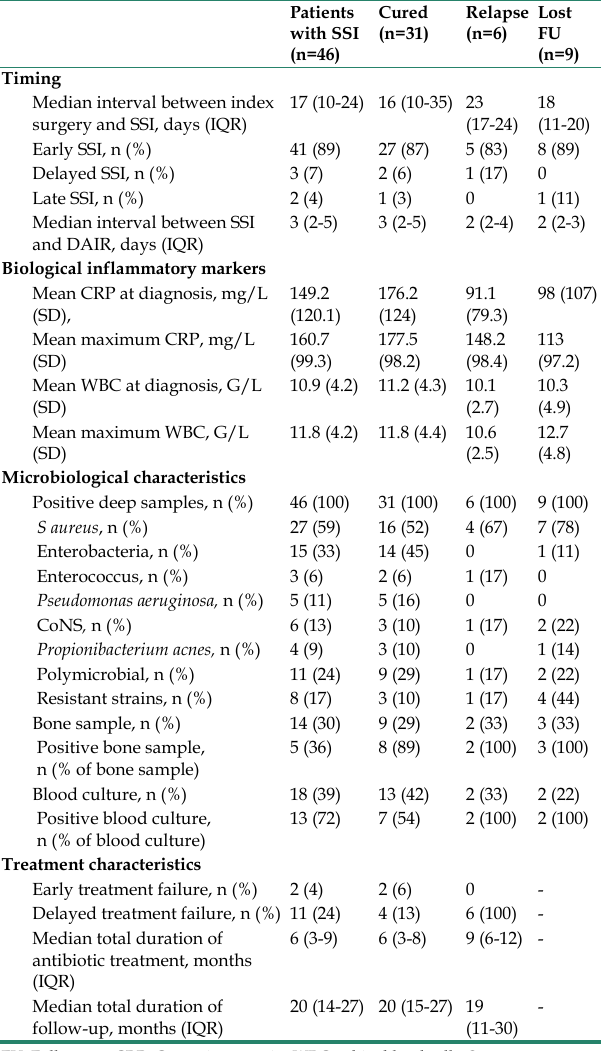
Table 3. SSI and treatment characteristics